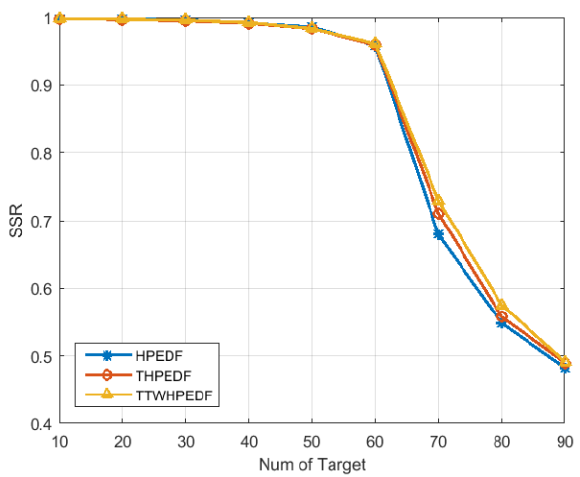
Figure 2. Comparison of scheduling success rates ( SSR ) of the three algorithms.